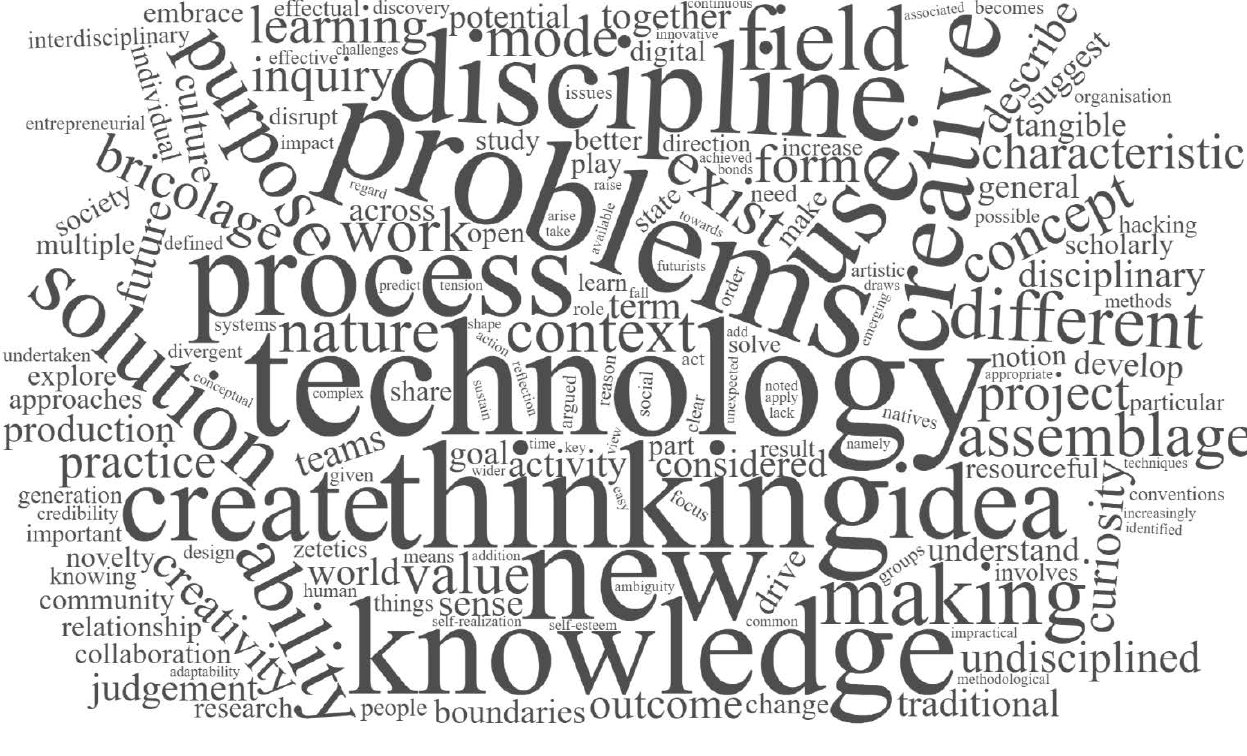
Figure 3. Creative Technologies Word